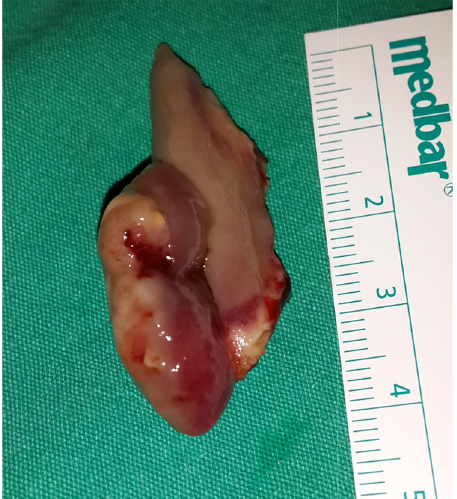
Figure 3 Excised mass; lobular, red-grayish, about 30 mm long and 10 mm diameter.